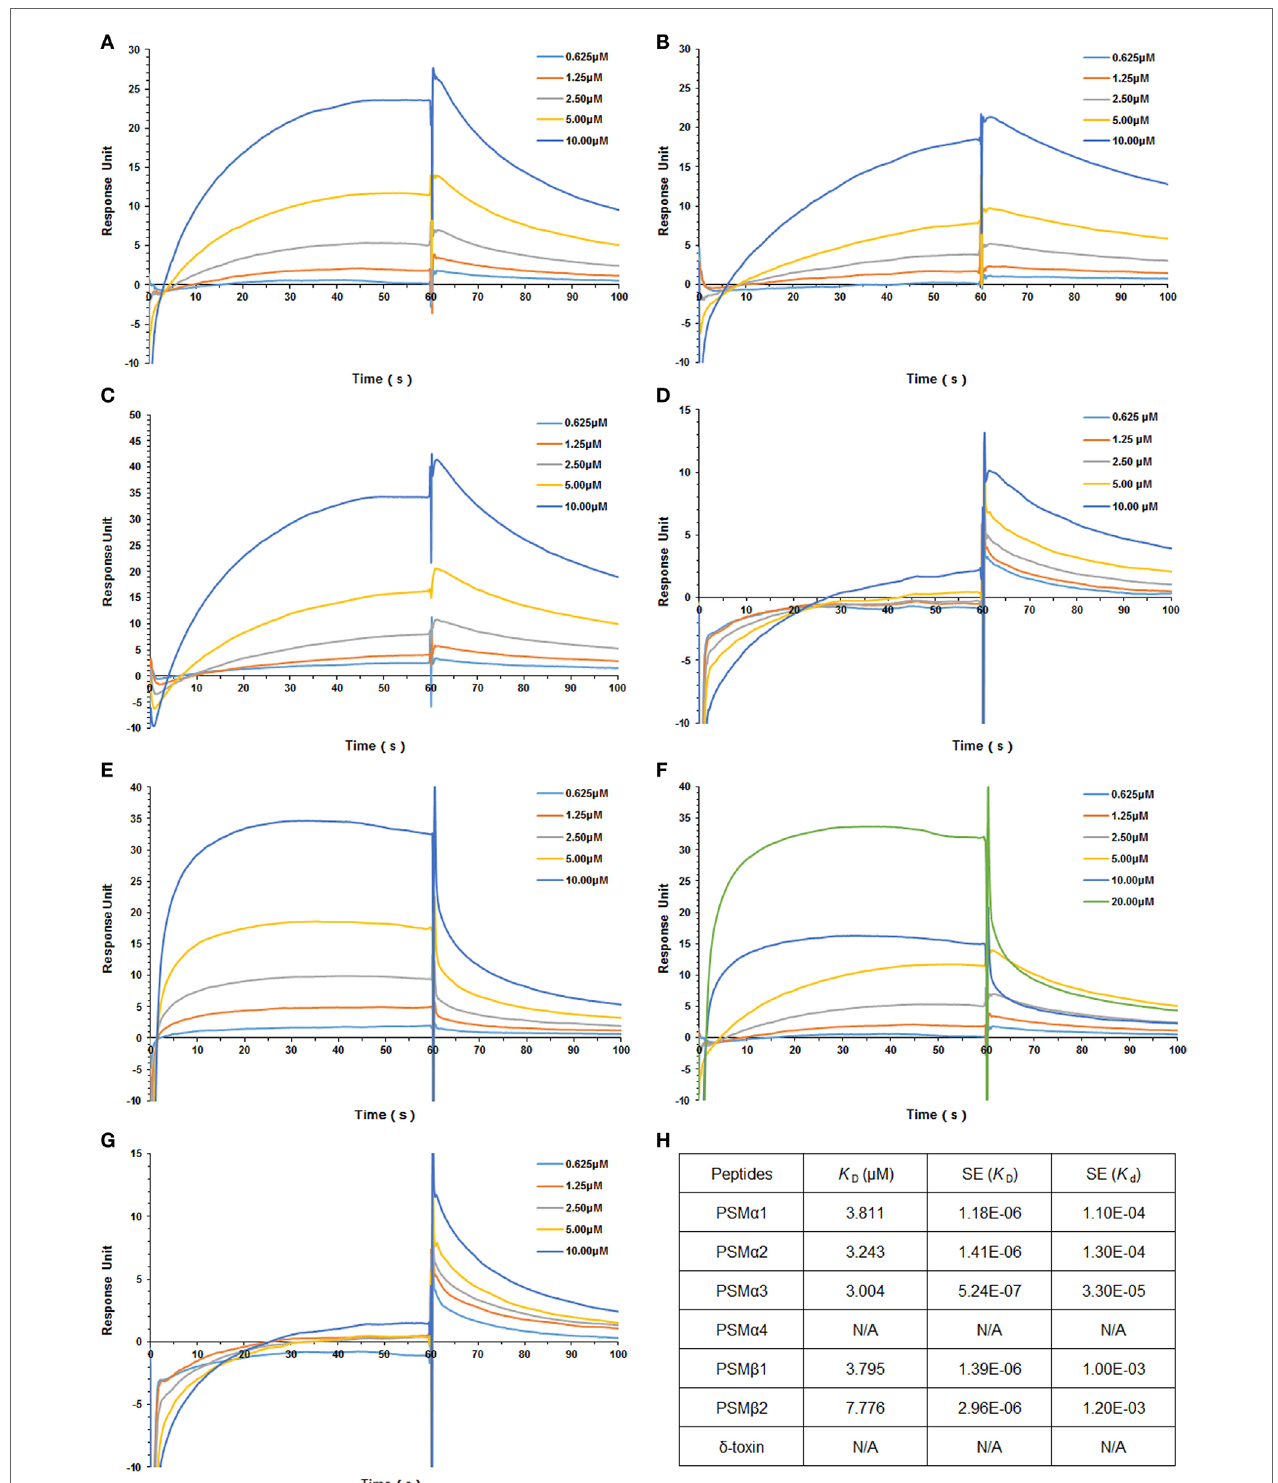
FigUre 1 | Staphylococcus aureus phenol-soluble modulins (PSMs) α 1– α 3 and β 1– β 2 bind to human TLR4 (hTLR4). Surface plasmon resonance analysis was performed to assess S. aureus PSMs binding to hTLR4 (coated on the chip), including PSM α 1 (a) , PSM α 2 (B) , PSM α 3 (c) , PSM α 4 (D) , PSM β 1 (e) , PSM β 2 (F) , and δ -toxin (g) . S. aureus PSMs binding to toll-like receptor (TLR) 4 was tested at different concentrations (0.625, 1.25, 2.5, 5.0, and 10.0 µM). (h) The binding affinity of TLR4 with S. aureus PSMs. K d represents the dissociation constant and K D represents the equilibrium dissociation constant. K D ( μ M), SE ( K D ), and SE ( K d ) were shown. Data are presented as response units over time (seconds) and are representative of three